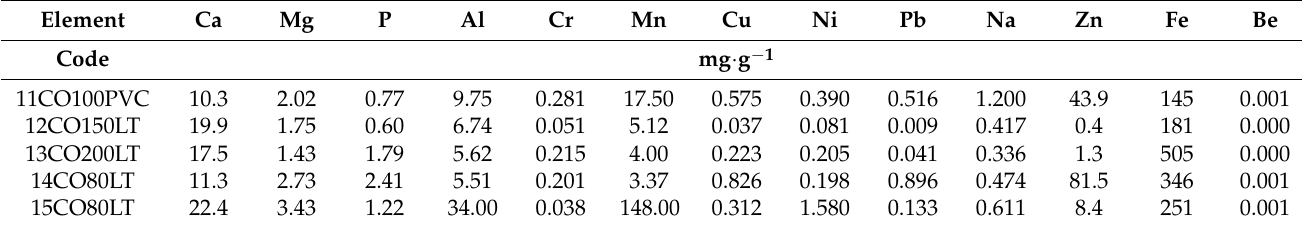
Table 4. Overview of measured element concentrations in solid phase by